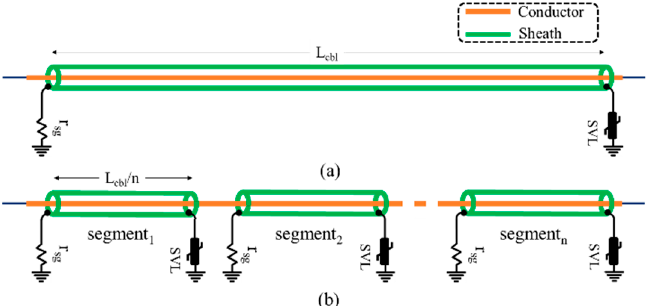
Figure 4. Schematic of a cable with (a) sheath grounded at one of the terminals, the other terminal is grounded via sheath voltage limiter (SVL): single point grounded (SPG). (b) multiple single point grounding (MSPG) of sheath.